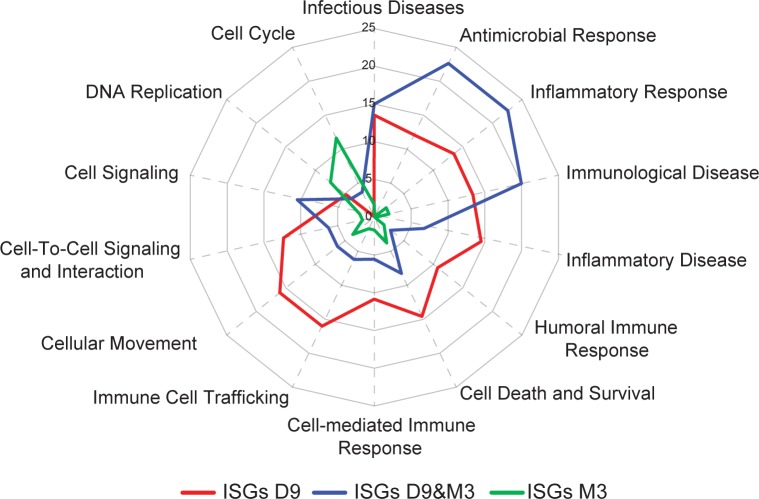
Evolution of the ISG-associated functional signature during infection.Functional enrichment of ISGs differentially expressed at either (A) D9 p.i., (B) M3 p.i., or (C) both time points (D9&M3), was performed using IPA. The right-tailed Fisher Exact Test with the Benjamini-Hochberg correction for multiple tests was used to identify processes showing statistically significant over-representation of focus ISGs. Over-represented functional or pathway processes have more focus genes than expected by chance and the–log(p-values) of the most significant functions are plotted in the radar plot.